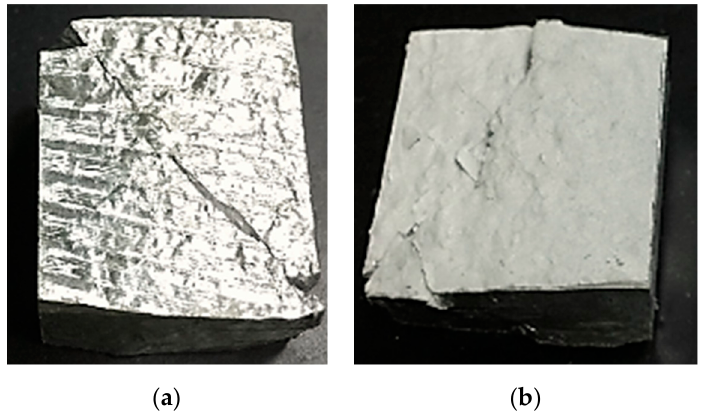
Figure 11. AM60 fractured sample after the compression test for: ( a ) BM, ( b ) BP50.